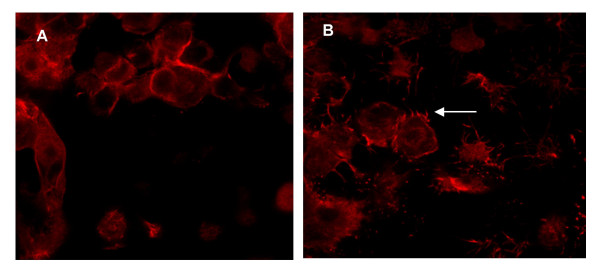
Phalloidin-TRITC staining of cells with and without EGF treatment. Cells were cultured on Transwell inserts, and confocal immunofluorescence microscopy performed following incubation with TRITC-conjugated phalloidin, in the absence (A) or presence (B) of 10 nM EGF. Arrow shows focal area of actin staining consistent with a focal adhesion complex.